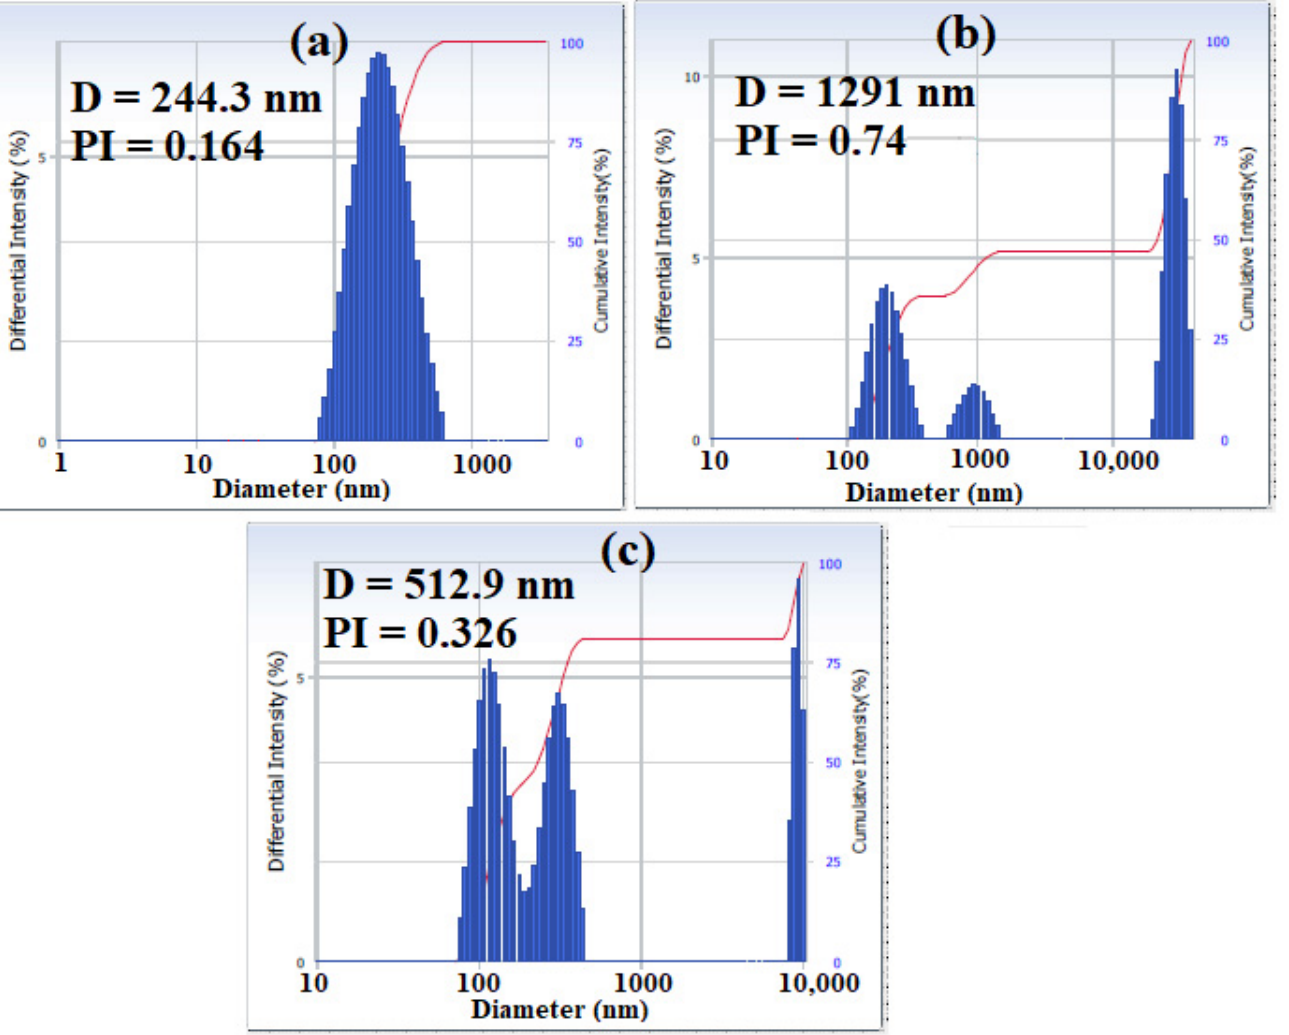
Figure 4. Particle size measurements of ( a ) QVP/MA-Fe 3 O 4 , ( b ) CQVP/MA, and ( c ) CQVP/MA-Fe 3 O 4 . The surface composition of CQVP/MA and CQVP/MA-Fe 3 O 4 samples was deter- mined using energy dispersion spectroscopy (EDS), as displayed in Figure 7a,b, and the results are listed in Table 1. The presence of MNPs in the PIL network was confirmed by the appearance of the Fe peak in Figure 7b, and the atomic (%) ratios of C/O/Br/Fe in CQVP/MA-Fe 3 O 4 were 44.88/26.17/2.84/26.17, respectively (Table